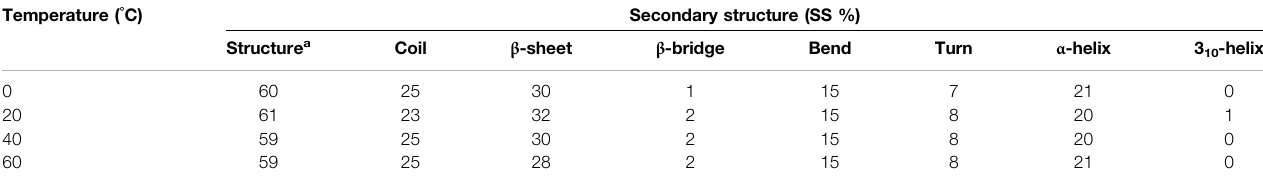
TABLE 1 | Percentage of residues in SARS-CoV-2 spike protein at 0, 20, 40, and 60 ° C contributed in mean structure development. Temperature ( ° C)